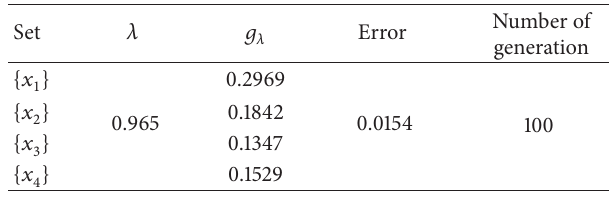
Table 6: Results of Example 17.